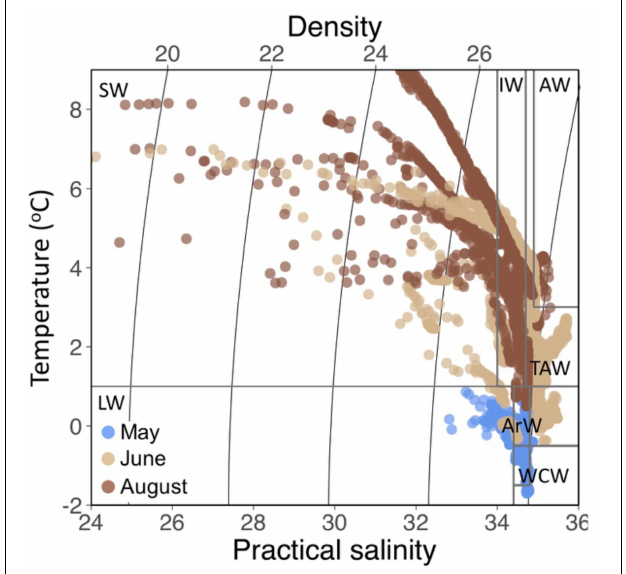
FIGURE 2 | TS diagram based on all CTD profiles by sampling month. Water masses were determined using categories specific to Isfjorden (Nilsen et al., 2008).